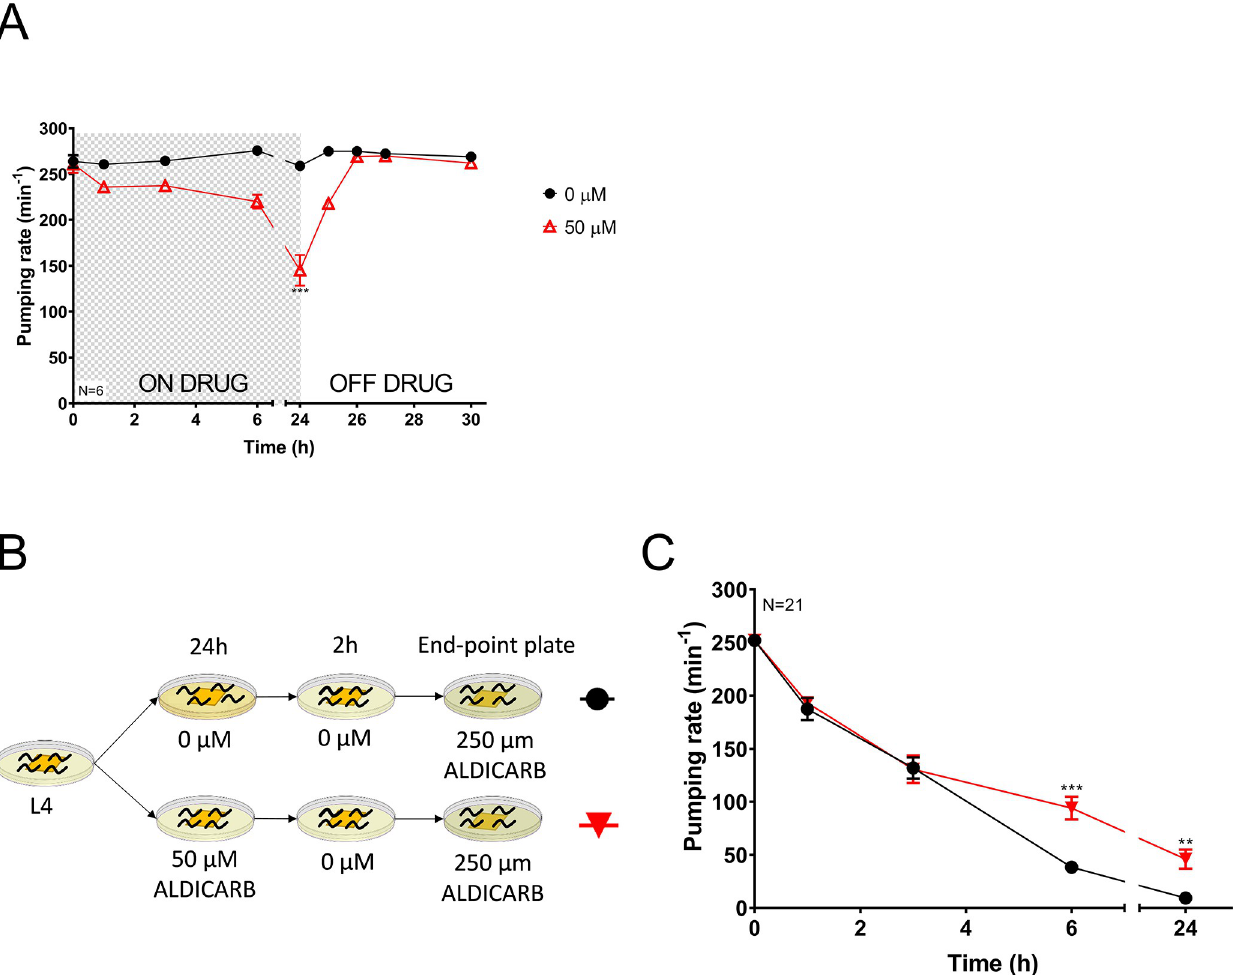
Fig 1. Aldicarb preconditioning reduces drug-induced inhibition of pharyngeal pumping. A) Pharyngeal pumping rate was quantified at indicated times for synchronized nematodes exposed to a sub-lethal dose of aldicarb. Nematodes were transferred to non-drug containing plates where the recovery of the pharyngeal function was observed at the indicated times. The shaded box indicates period of treatment. Data are shown as mean ± SEM of 6 worms in 3 independent experiments (N = 6). Statistical significance between exposed and non-exposed nematodes was calculated by two-way ANOVA test followed by Bonferroni correction. ** p � 0.01. B) Synchronized L4 worms were incubated on 50 μ M aldicarb plates. Non-exposed nematodes were used as controls. After 24 hours, worms were transferred to non-drug plates to allow the recovery of the pharyngeal function before subsequent exposure to 250 μ M aldicarb for measurement of pharyngeal pumping C) Preconditioned worms exhibited higher pharyngeal pumping rate than non-preconditioned animals 6 and 24 hours after being transferred to plates containing 250 μ M aldicarb. Data are mean ± SEM of 21 worms in at least 11 independent experiments (N = 21). Statistical significance between preconditioned and non-preconditioned nematodes was calculated by two-way ANOVA test followed by Bonferroni correction. ** p � 0.01; *** p � 0.001.